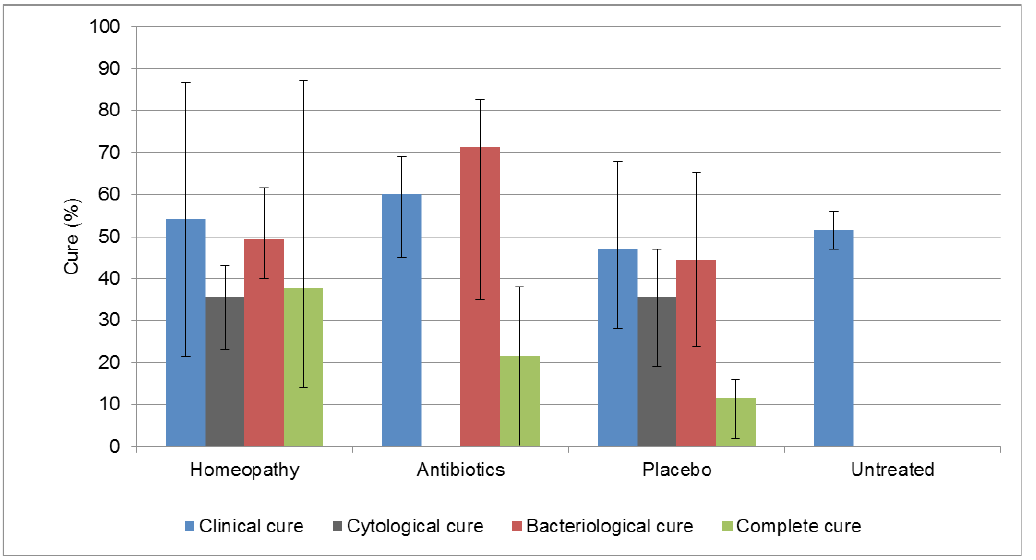
Figure 2: Cure of clinical mastitis as percentage mean value in four trial groups. Note: The bar chart of figure 2 shows the results of studies of clinical mastitis (data see Table 4) in percentages as mean values and the minimum and maximum values as lines. The results shown in the antibiotics group include the results of the three further studies mentioned